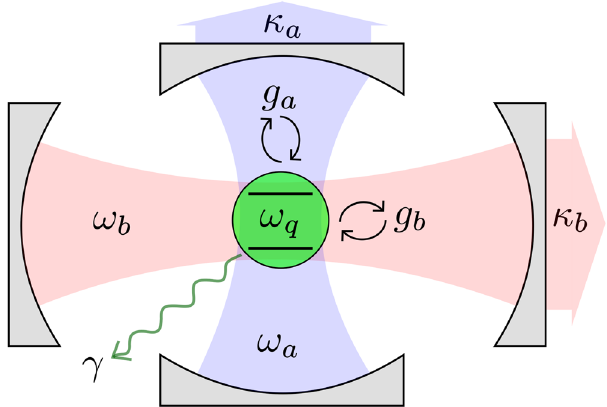
Figure 1. A sketch of the system. A qubit (green) is coupled to two resonator modes (blue, a , and red, b ). Decoherence channels for the qubit (relaxation rate γ ) and the resonators (relaxation rates κ a , κ b ) are